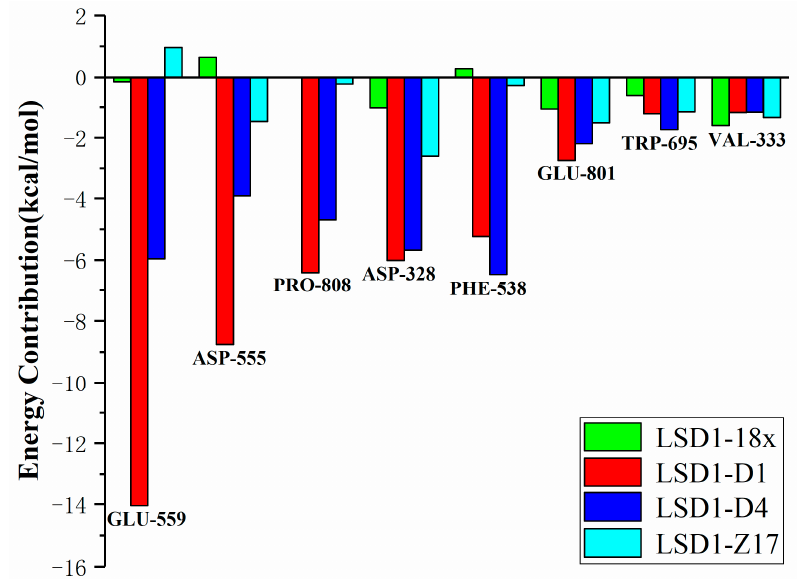
Figure 8. Binding free energy decomposition plot.